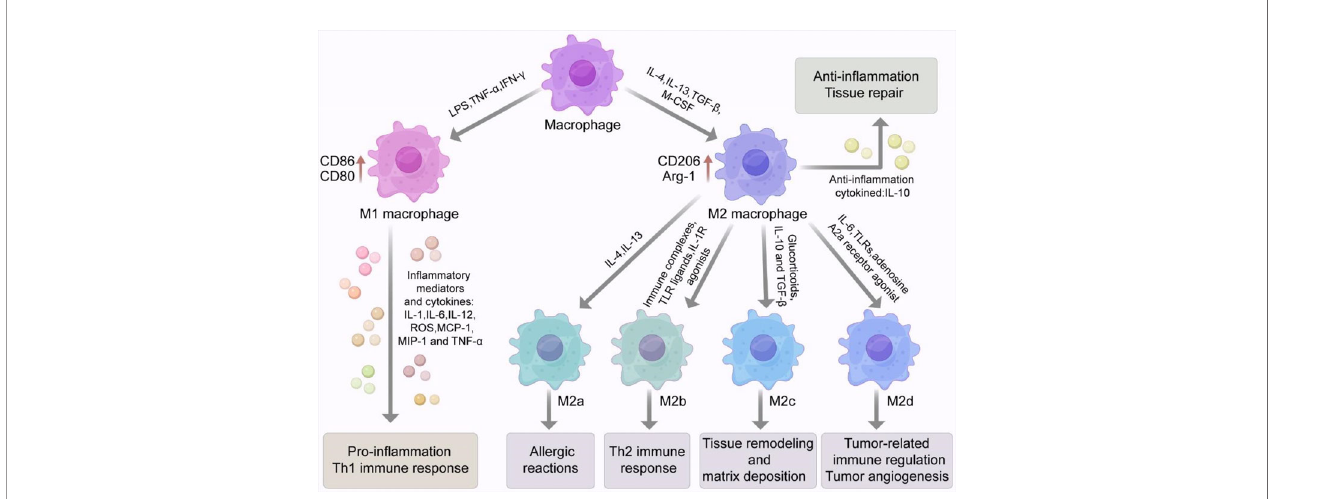
FIGURE 1 | Macrophage phenotype and polarization. Macrophages have good plasticity and can differentiate into two phenotypes, classically activated M1 macrophages or alternatively activated M2 macrophages under different environmental conditions. Stimulated by LPS or Th1 related cytokines such as IFN- g and TNF- a , macrophages can polarize into the M1 phenotype with high expression of surface markers such as CD86 and CD80. M1 macrophages can secrete a variety of pro-in fl ammatory cytokines and in fl ammatory mediators that can cause a strong in fl ammatory response and cause tissue damage. M2 macrophages are usually induced by IL-4, IL-13, TGF- b and M-CSF. M2 macrophages highly express speci fi c surface markers such as CD206, CD163, Arg-1, Ym-1 and Fizz 1. M2 macrophage also secrete a large amount of the anti-in fl ammatory cytokine IL-10, which inhibits in fl ammatory responses and participates in tissue repair. M2 macrophages can be divided into four subtypes (M2a, M2b, M2c, M2d). Activation of M2a macrophages is induced by IL-4 and IL-13 and may be involved in allergic reactions. M2b macrophages are induced by immune complexes (ICs), Toll-like receptor (TLR) ligands and IL-1R agonists. Glucocorticoids, IL-10 and TGF- b are involved in the induction of M2c macrophages and may be involved in tissue remodeling and stromal deposition. M2d macrophages are induced synergistically by TLR and adenosine A2a receptor agonists or IL-6. With the characteristics of tumor-like macrophages, they can be involved in tumor-associated immune regulation and tumor